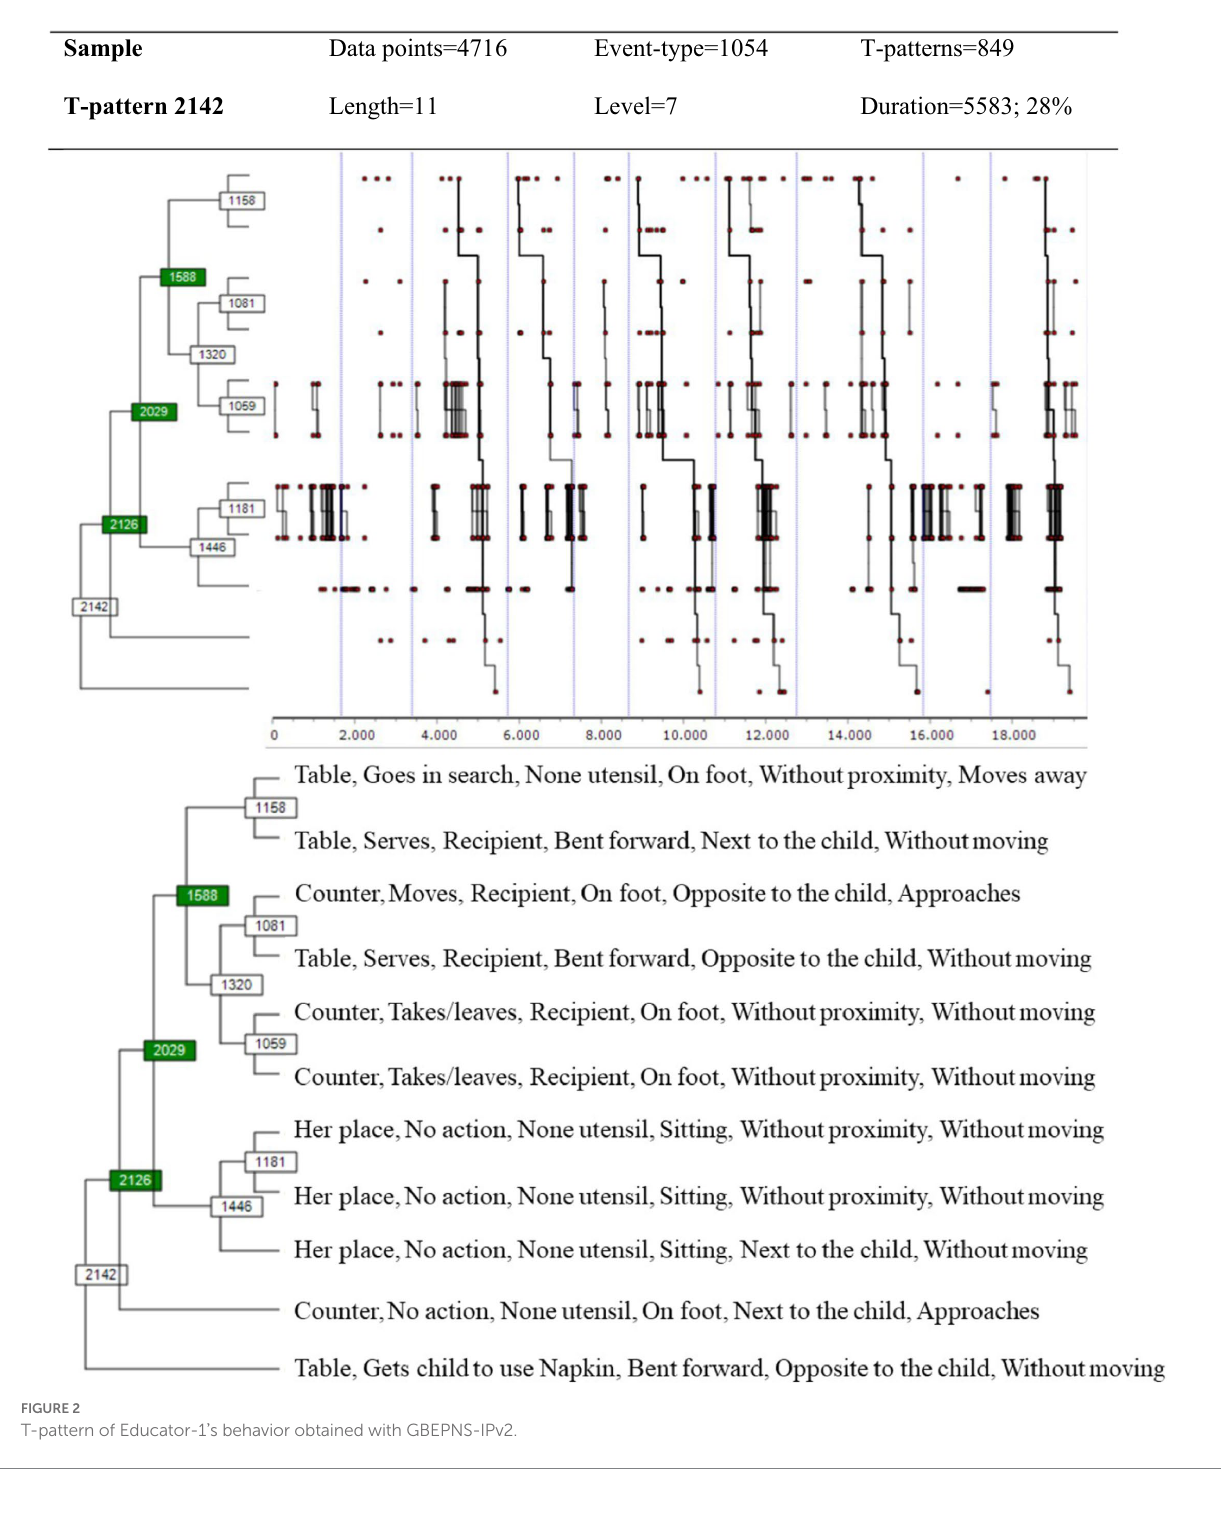
detected in the behavior of Educator-2. In this pattern there are three event-type sub-sets, which, although differing slightly in how they are structured in relation to Educator-1 ʼ s T-pattern, they practically replicate its composition: chain linking of instrumental actions ( serves, puts, moves, takes/leaves ) that alternate movements ( moves nearer, moves away ) between the counter and the table ; again, there are repetitions of the central sub-set of accompaniment when there is no action , and finally, the use of the napkin